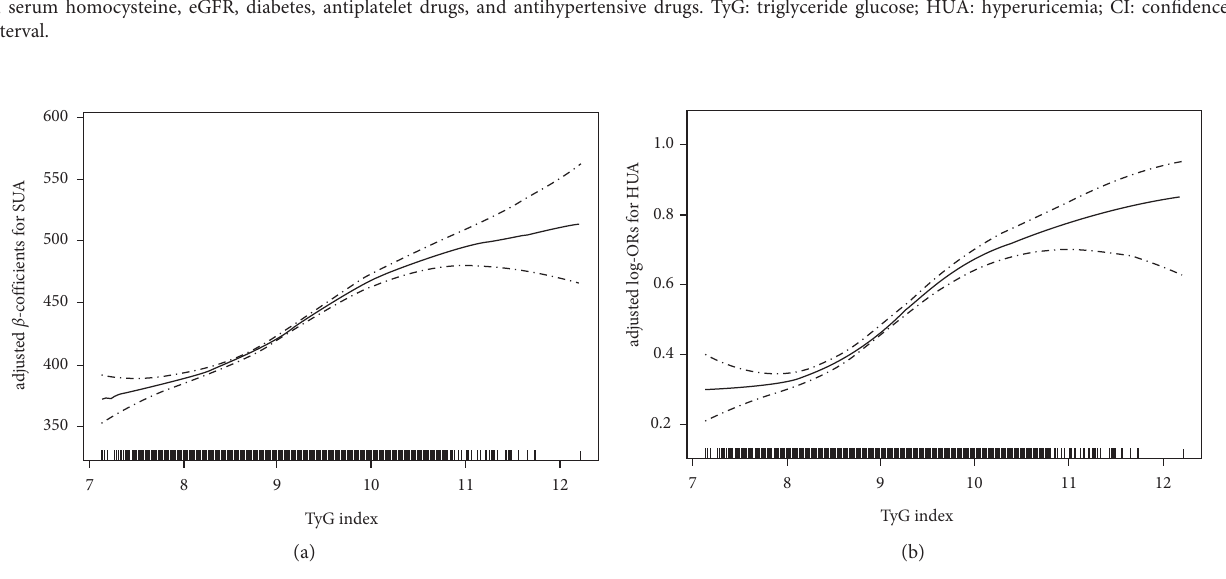
Figure 2: Dose-response association between the TyG index and SUA. (a) TyG index and SUA; (b) TyG index and hyperuricemia. All adjusted for age, gender, education, smoking, drinking, physical activity, waist circumference, BMI, SBP, DBP, eGFR, serum homocysteine, HDL-C, LDL-C, diabetes, antiplatelet drugs, and antihypertensive